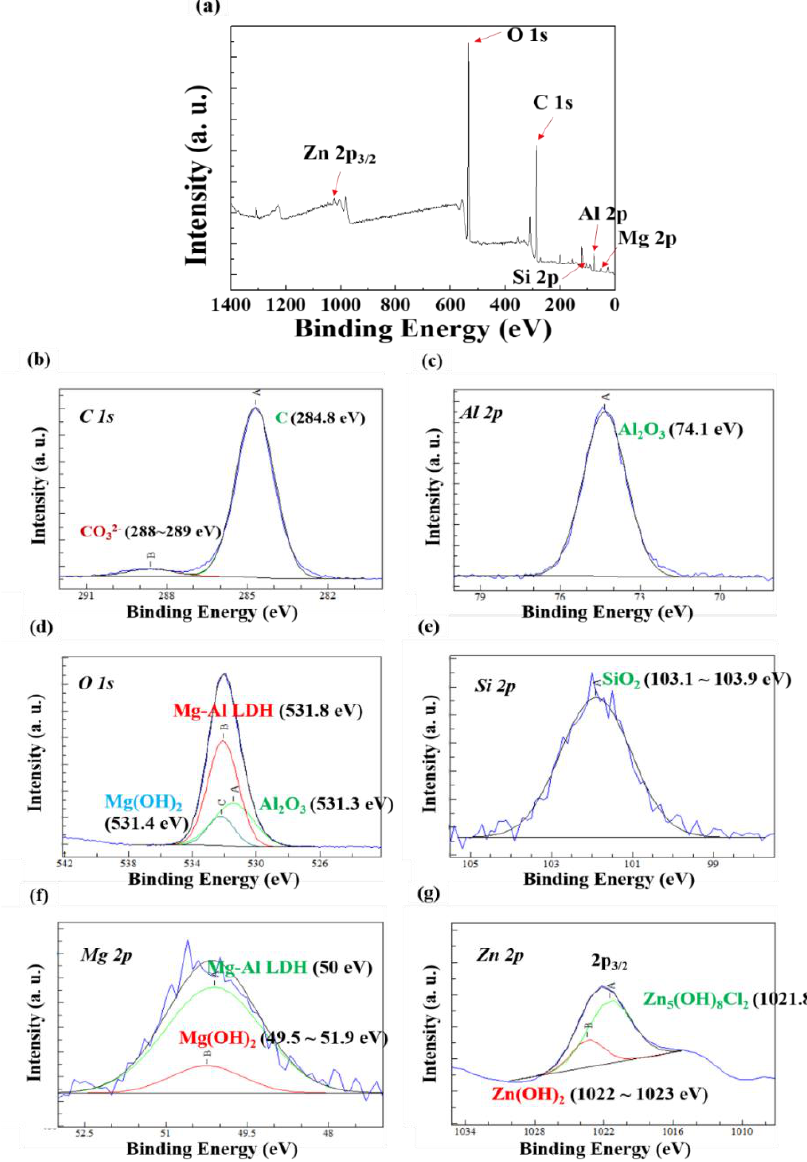
Figure 9. ( a ) XPS survey spectrum and ( b – g ) high-resolution spectra of the surface on AlSiZnMg-MC after PS test.